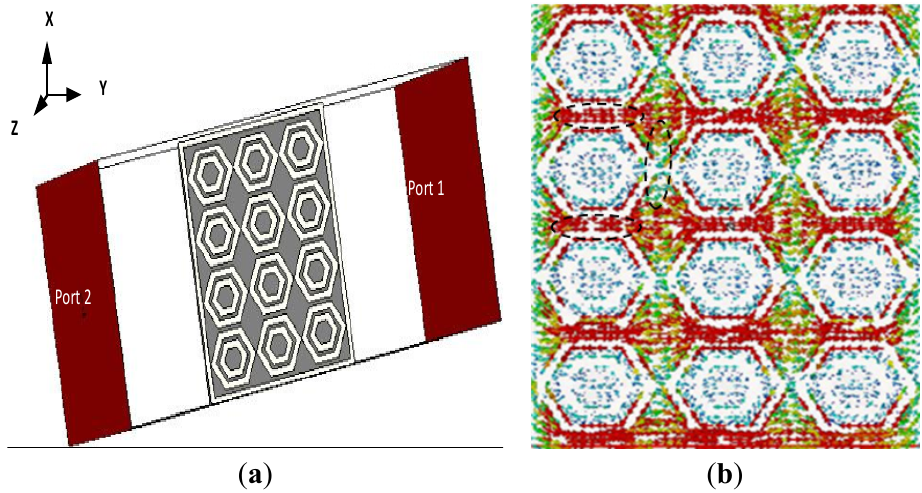
Figure 2. ( a ) Simulation arrangement of a unit cell array of metamaterial characteristics; ( b ) Surface current distribution at 1.97 GHz.